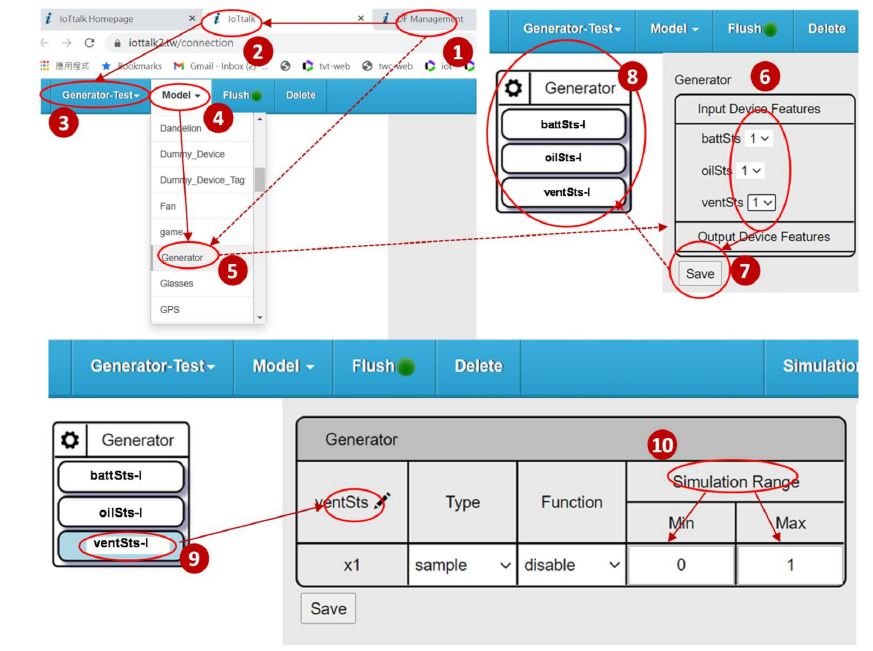
Figure 6. Specifying the generator under test.